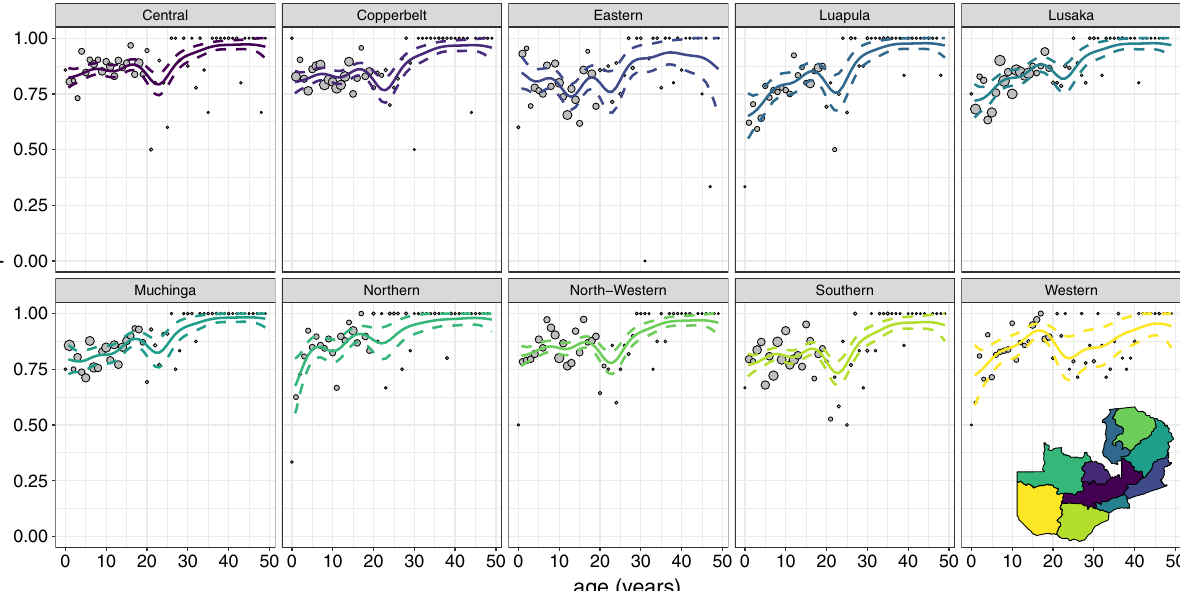
Figure 2. Measles age-specific seroprevalence by province. The points represent the data grouped by age in years with the exception of year 0 which includes only individuals 10 and 11 months old and are proportional to the number of individuals in each age in years. The lines represent the generalized additive model mean (solid line) and 95% confidence intervals (dashed lines).